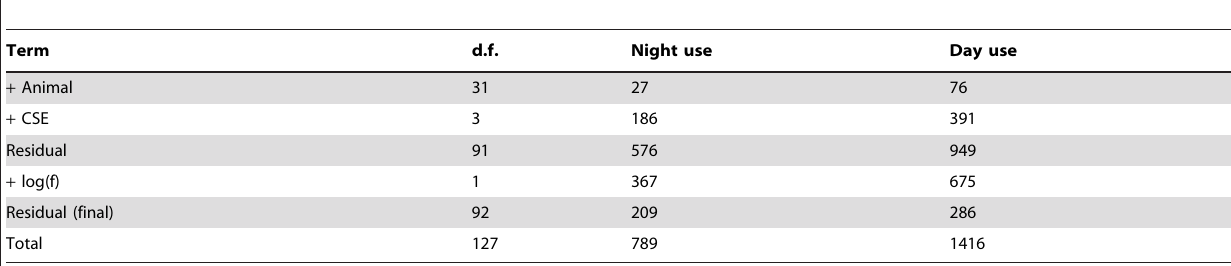
Table 2. Accumulated analysis of deviance Table after fitting a sequence of log-linear Poisson models (see section ‘The Model’).